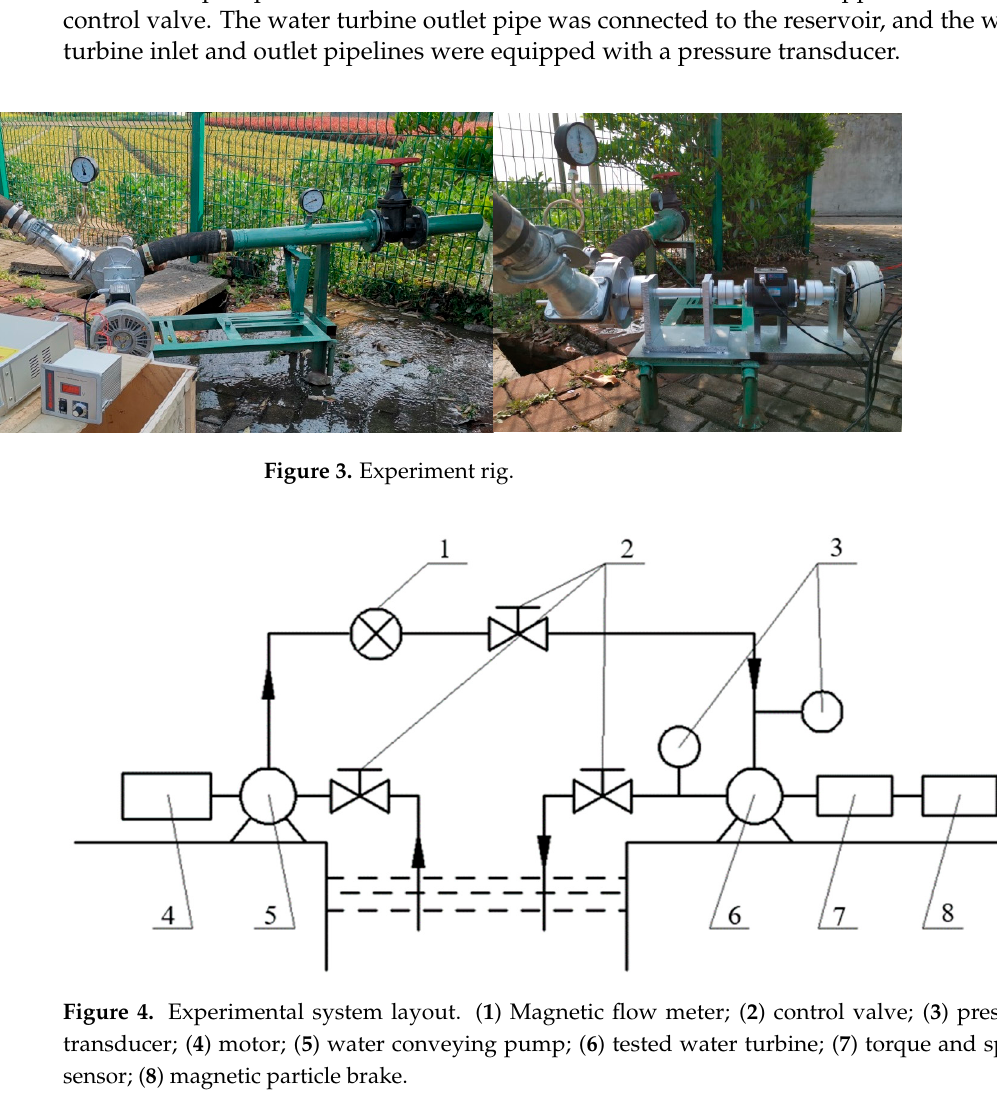
sensor; ( 8 ) magnetic particle